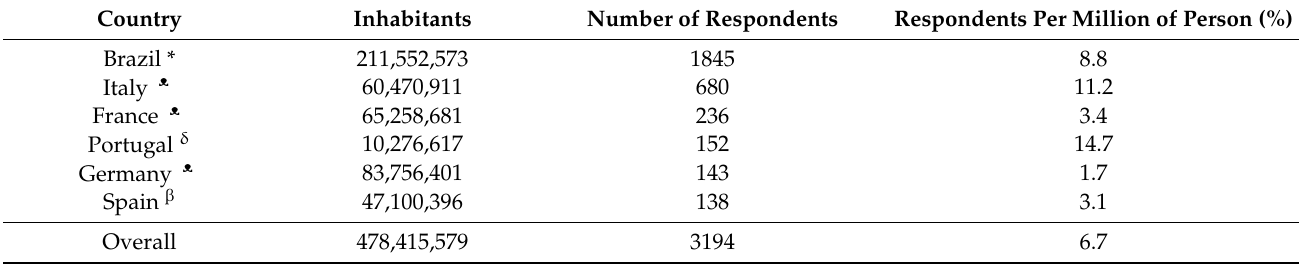
Table 1. Number of respondents per millions of people of the countries’ inhabitants.